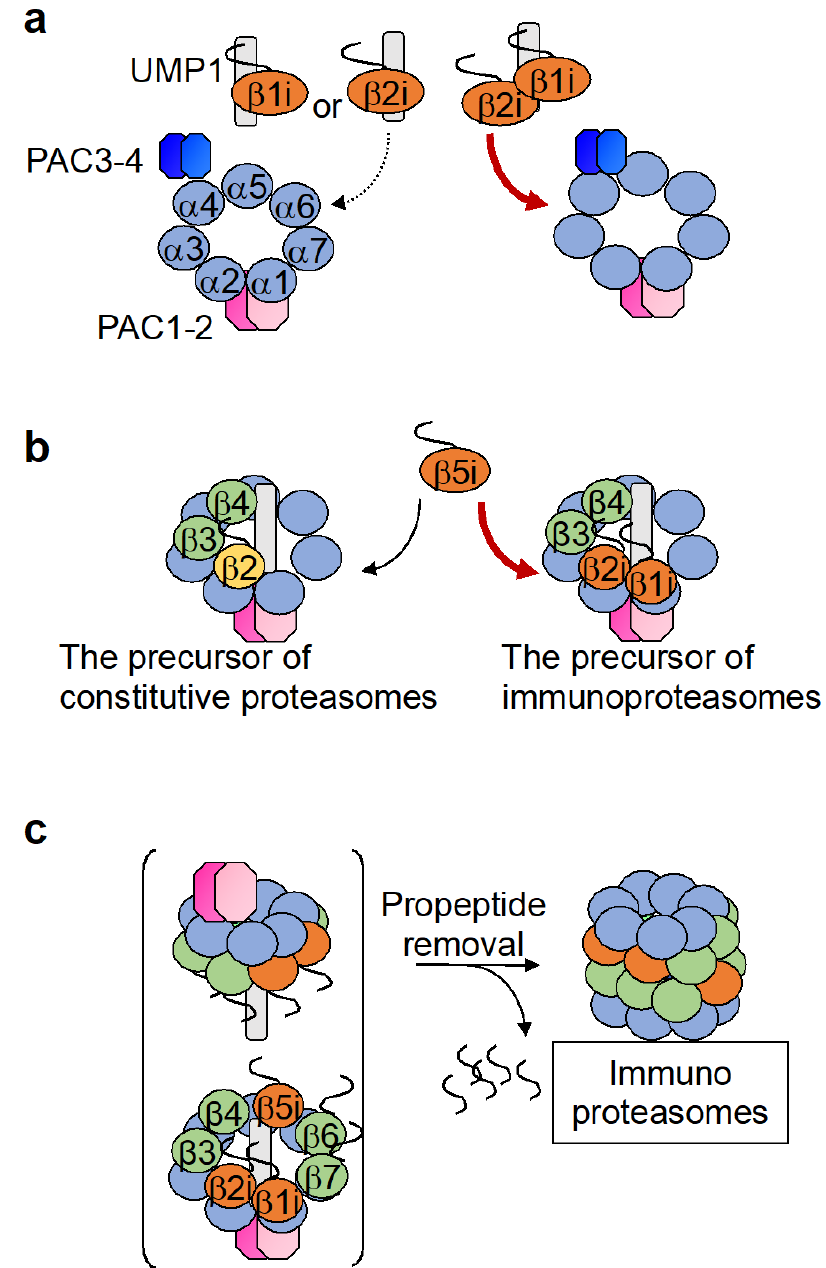
Figure 4. Incorporation of the three immunosubunits into the immunoproteasome. ( a ) β 1i and β 2i are mutually required for their incorporation during immunoproteasome assembly. Please note that the intermediate containing sole β 1i or β 2i with the α -ring has not been observed. ( b ) The precursor complex containing β 1i and β 2i promotes the incorporation of β 5i. ( c ) The incorporation of β 5i is necessary for removal of the β 1i and β 2i propeptides.